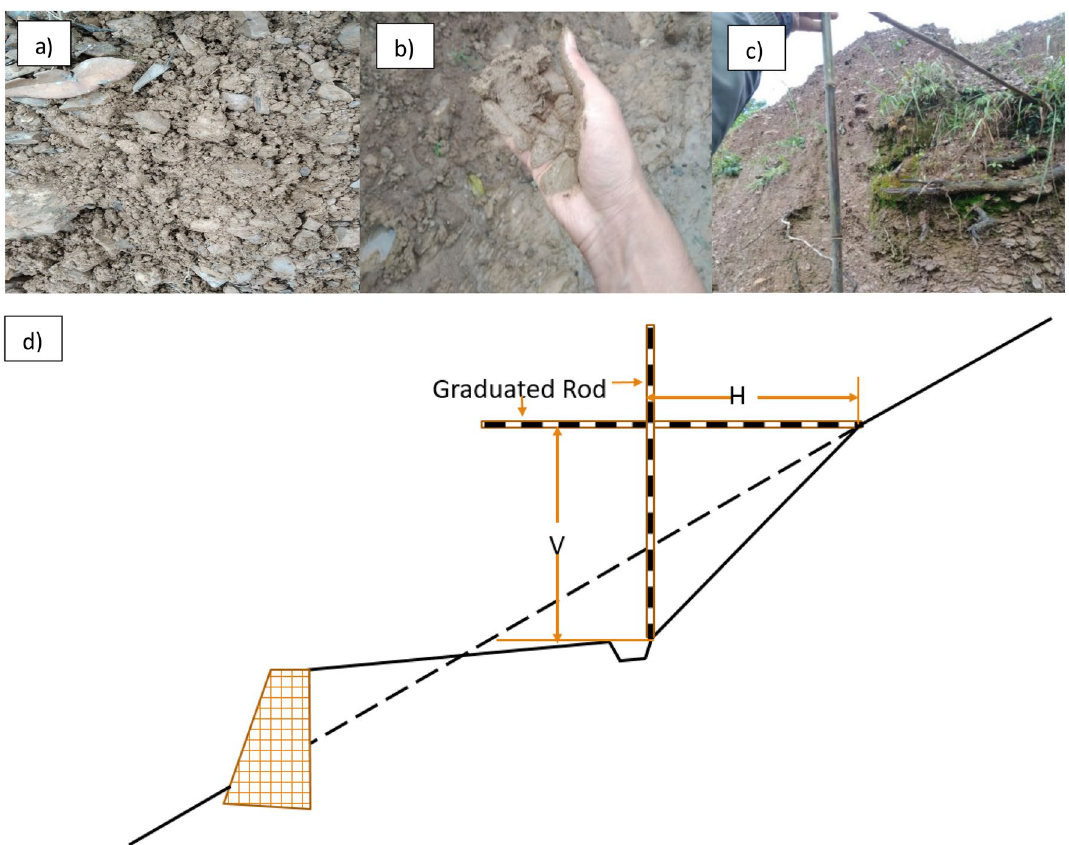
Fig. 5 General field assessment